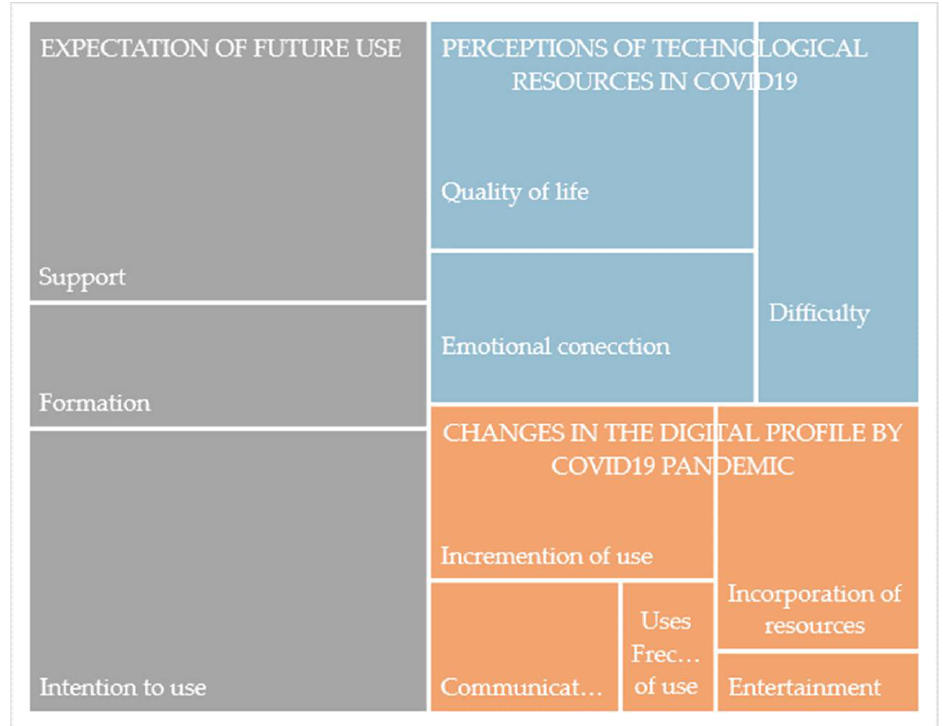
Figure 2. Hierarchical map of the discourse according to number of coding references. Words cut off by the graph: Communicat… = Communication; Frec… of use = Frecuency of use. Table 1. Study dimensions and